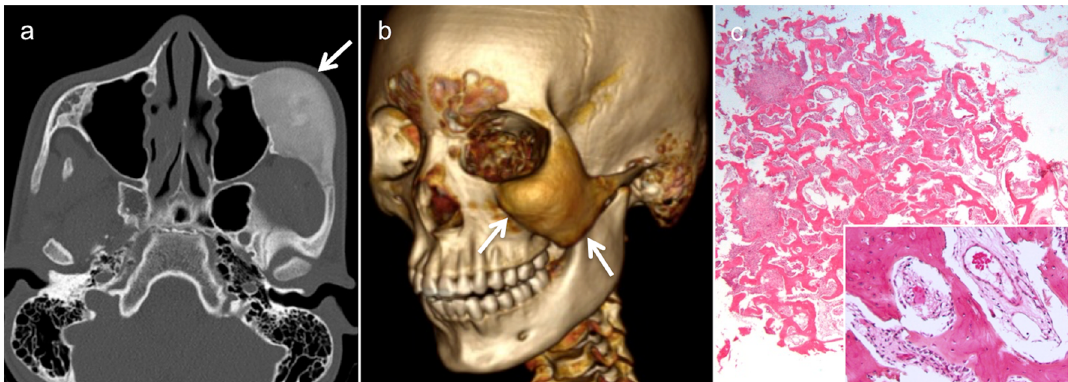
Fig. 1 Fibrous dysplasia (FD) of the maxilla in a 12-year-old boy with rapidly increasing facial asymmetry. a Axial computed tomography (CT) scan (bone window) shows expansile lesion of the left zygomatic arch with ground-glass opacity ( arrow ). b Three-dimensional CT volume rendering (VR) reconstruction depicts zygomatic bone remodelling involving the floor and lateral wall of the orbit and the zygomatic arch ( arrows ). Partial surgery was performed six years later for